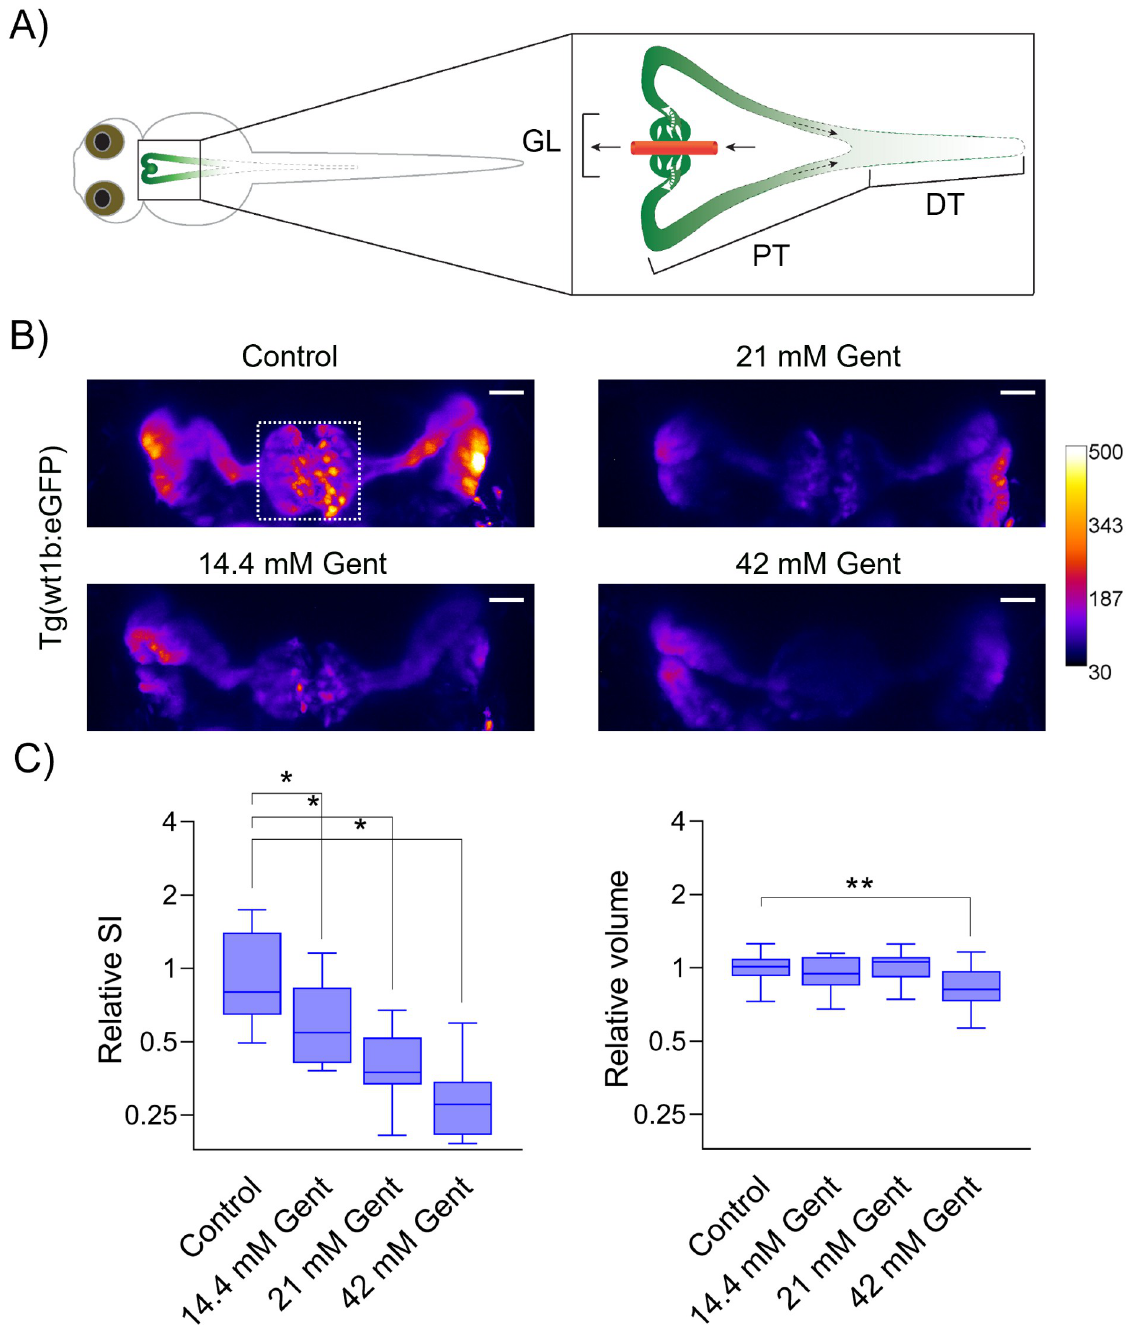
Fig 2. Gentamicin-induced damage to the pronephros in 96 hpf Tg(wt1b:eGFP) ZFL. (A) Schematic representation of renal pronephros in 96 hpf ZFL. GL: glomerulus, PT: proximal convoluted and straight tubule, DT: distal early and late tubule. Pronephros are fused together at the midline above the yolk and heart. Transgenic expression of eGFP leads to a fluorescent signal (green) in the glomerulus and upper parts of the tubules. (B) 72 hpf Tg(wt1b:eGFP) ZFL were injected with 1 nL of 14.4 mM to 42 mM gentamicin. Representative images of maximum projections. The color-coded heat map indicates SI, e.g. white correlates to high SI values and black to weak SI. Scale bar: 25 μ m. Gent: gentamicin. (C) Relative SI and relative volume of the glomerulus (panel B, white dotted rectangle) as compared to normalized control is shown using a box-and-whisker plot, n � 10 ZFL. * p < 0.001, ** p <